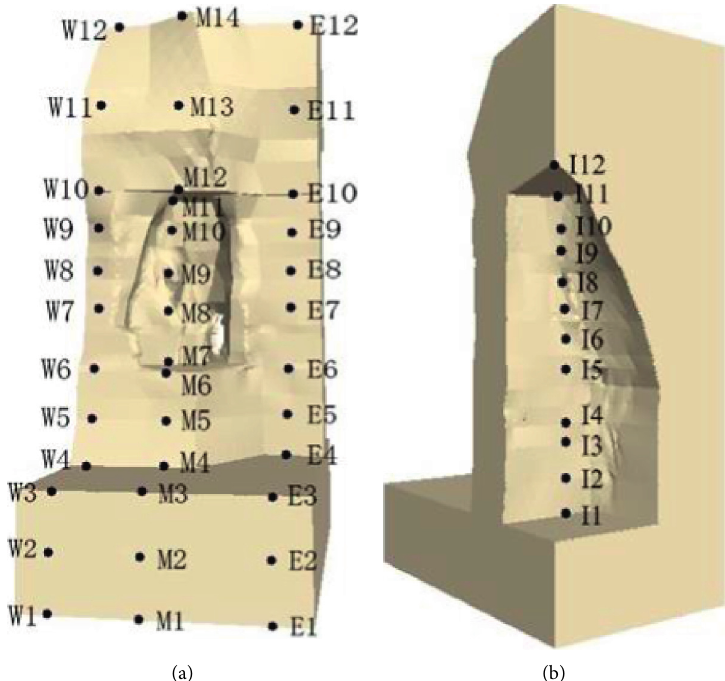
Figure 9: Distribution of monitoring points: (a) a total of 38 monitoring points were set up in groups E, M, and W on the model facade; (b) inner wall monitoring points were set up with a group of 12 monitoring